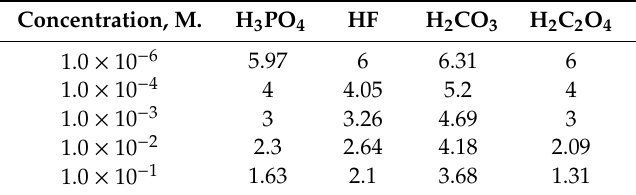
Table 4. The pH values of some weak acids for various concentrations.